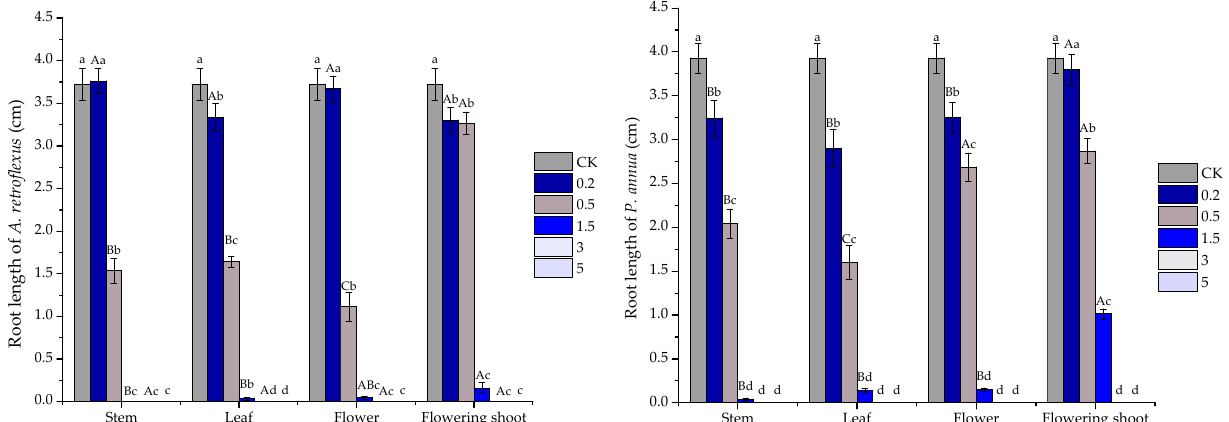
Figure 2. Phytotoxic effect of stem, leaf, flower and flowering shoot volatile oils of S. kaschgaricum on root elongation of A. retroflexus and P. annua . Each value is the mean of five replicates ± SE ( n = 50). Different lowercase letters (a, b, c, etc.) indicate significant differences among different concentrations (0 mg/mL(CK), 0.2 mg/mL, 0.5 mg/mL, 1.5 mg/mL, 3 mg/mL and 5 mg/mL) of the same oil treatments at p < 0.05 level according to Fisher’s LSD test, and different uppercase letters (A, B, C, etc.) indicate significant differences among stem, leaf, flower and flowering shoot volatile oils at the same concentration (Fisher’s LSD test, n = 50, p < 0.05).